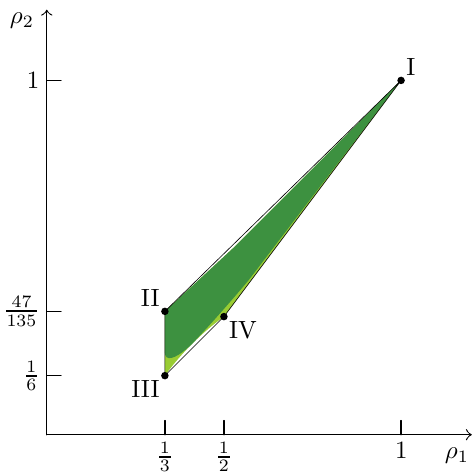
Figure 1 . The orbit space of the representation 15 0 is shown in green. Dark green represents the region where a U(1) subgroup can be preserved. An SU(2) subgroup is only preserved on the cusp (cid:26) 1 = (cid:26) 2 = 1. The convex hull of the orbit space is a simplex. Its borders are shown with lines joining the vertices of the orbit